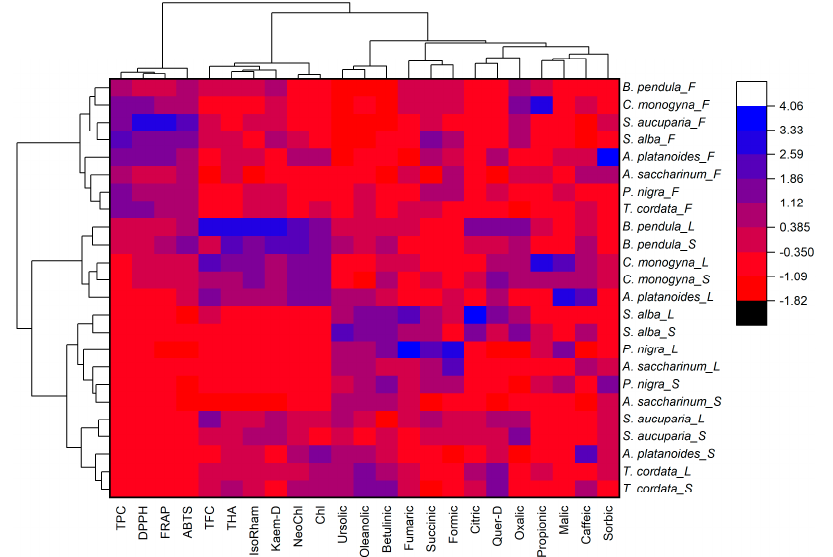
Figure 1. Heat map with clusters of the studied phytochemical parameters (at the top) and mistletoe samples (at the left). TPC—total phenolics content; TFC—total flavonoids content; THA—total hy- droxycinnamic acids; IsoRham—isorhamnetin; Quer-D—quercetin derivative; Kaem-D—kaempferol derivative; DPPH—antioxidant activity determined by DPPH (2,2-diphenyl-1-picrylhydrazyl) assay; ABTS—antioxidant activity determined by ABTS (2,2 (cid:48) -azino-bis(3-ethylbenzothiazoline-6-sulfonic acid)) assay; FRAP—ferric reducing/antioxidant power. The uppercase letters following the host tree species indicate F—fruits, L—leaves, and